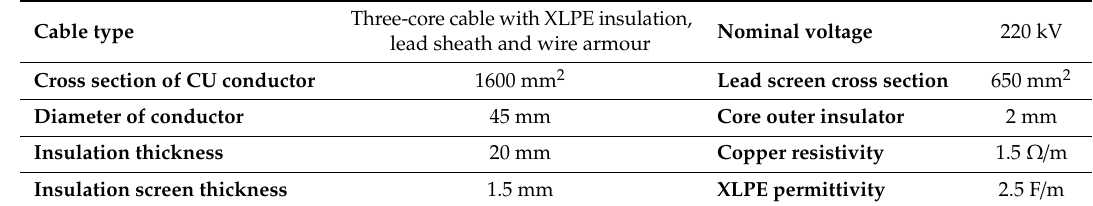
Table A2. Submarine cable data implemented in PSCAD.